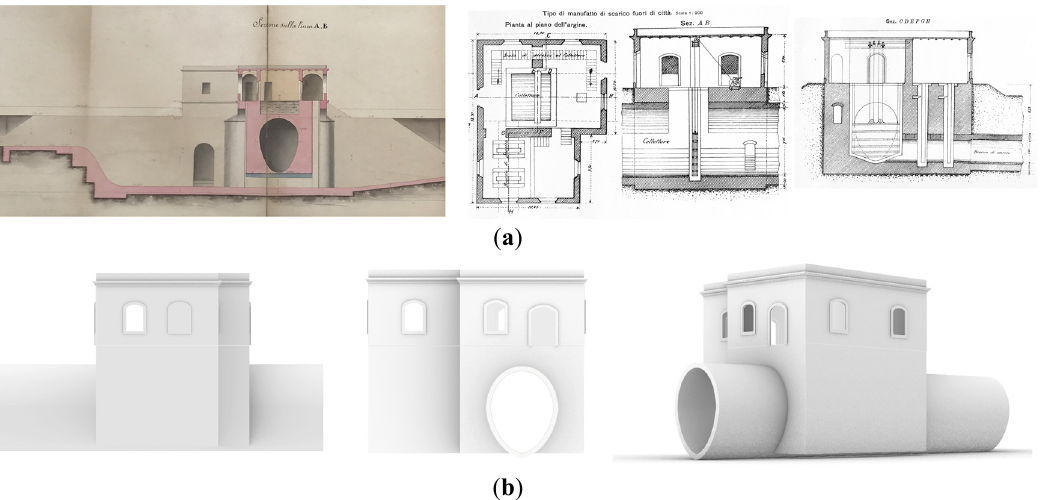
Figure 7. ( a ) Original design drawings of the building of the Collector sewer’s point of disposal n. 7 , 1882 (courtesy of Rome State Archive, Ufficio Speciale per il Tevere e l’Agro Romano collection); ( b ) 3D model of the building of the Collector sewer’s point of disposal n. 7 with the Collector sewer underground tunnel.